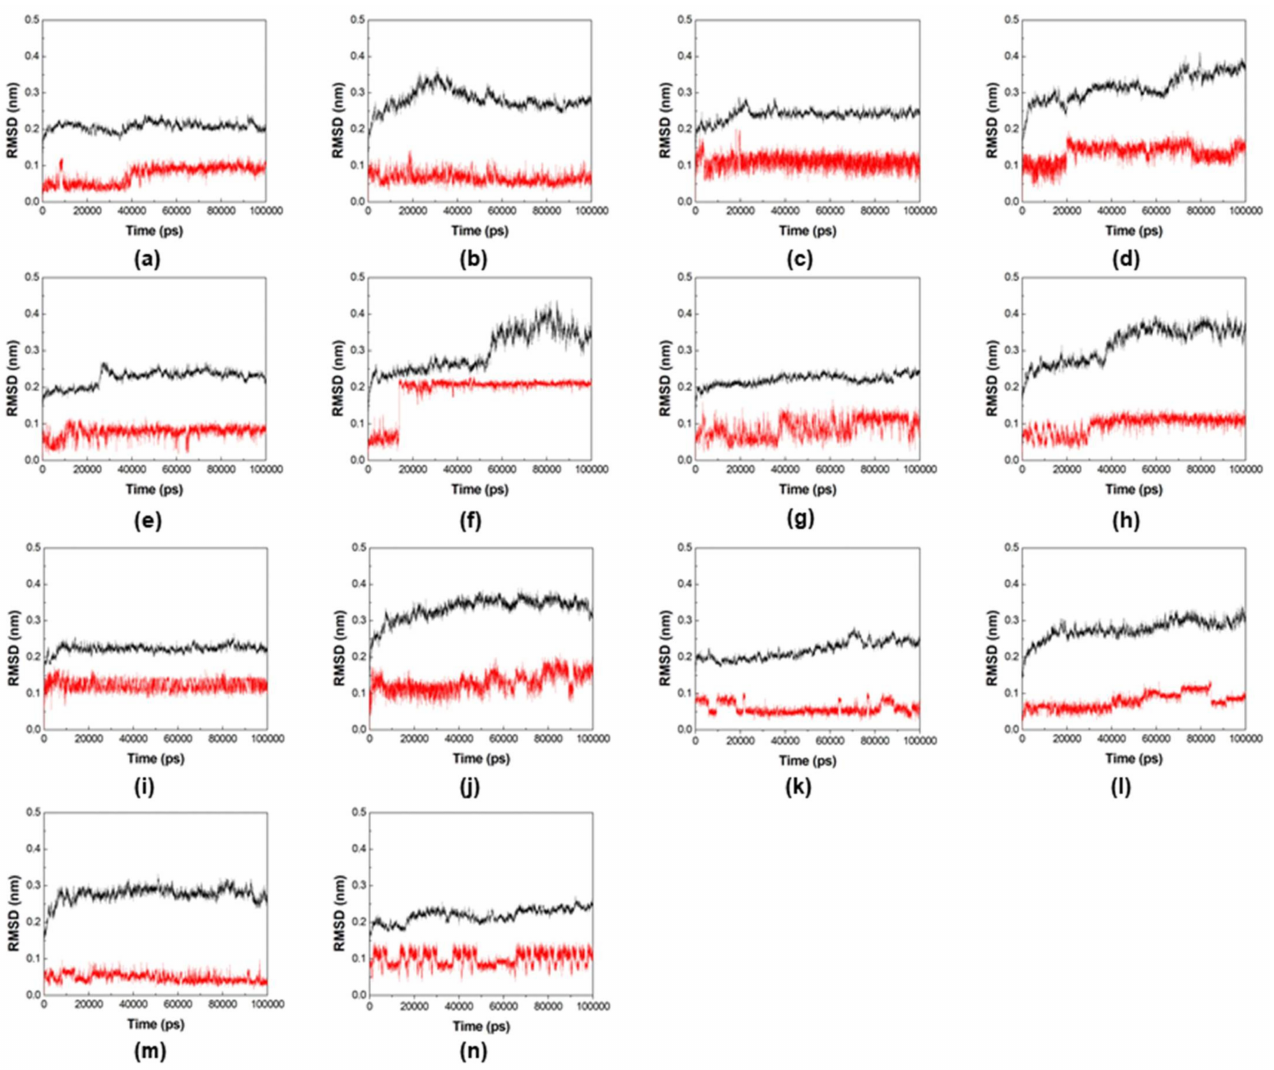
Figure 4. RMSD of the systems formed by the enzymes (in black) and compounds (in red): ( a ) Var TMPK/compound 2 , ( b ) Hss TMPK/compound 2 , ( c ) Var TMPK/compound 3 , ( d ) Hss TMPK/compound 3 , ( e ) Var TMPK/compound 4 , ( f ) Hss TMPK/compound 4 , ( g ) Var TMPK/compound 5 , ( h ) Hss TMPK/compound 5 , ( i ) Var TMPK/compound 6 , ( j ) Hss TMPK/compound 6 , ( k ) Var TMPK/compound 8 , ( l ) Hss TMPK/compound 8 , ( m ) Var TMPK/compound 9 , ( n ) Hss TMPK/compound 9